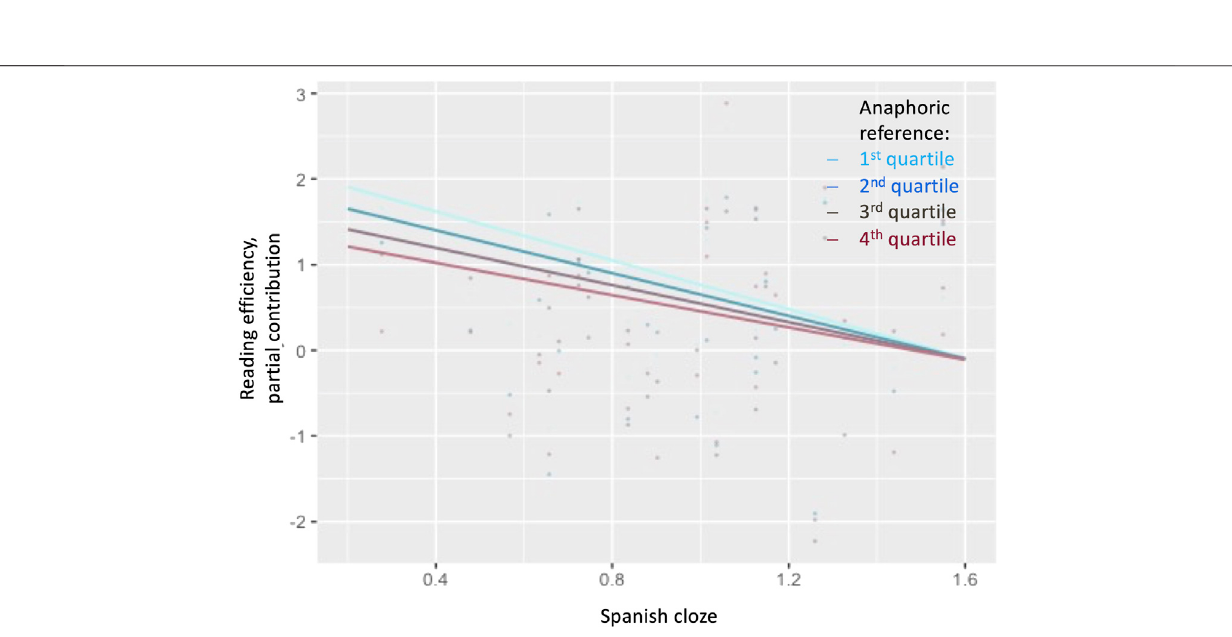
Frontiers in Communication |